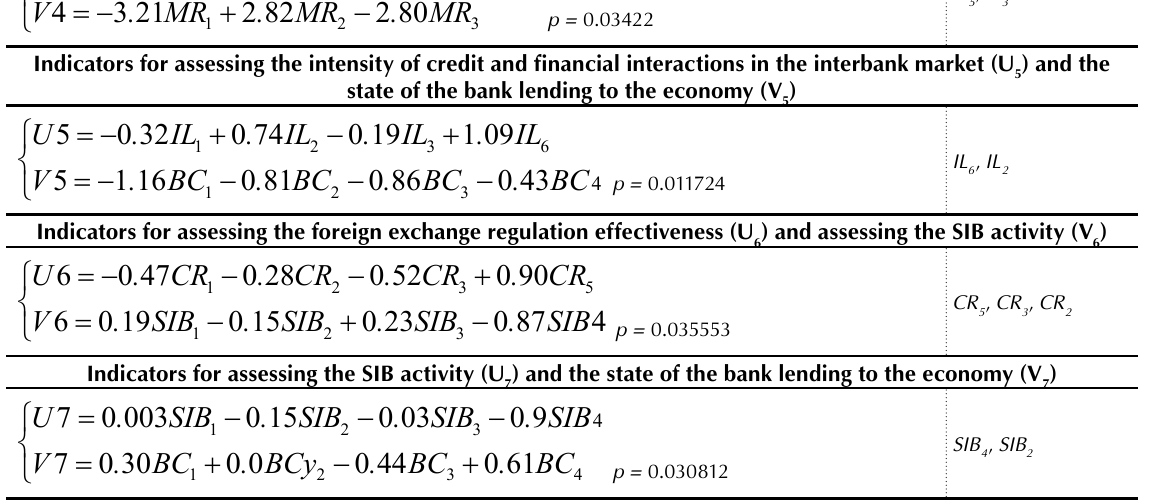
) and financial 8 8